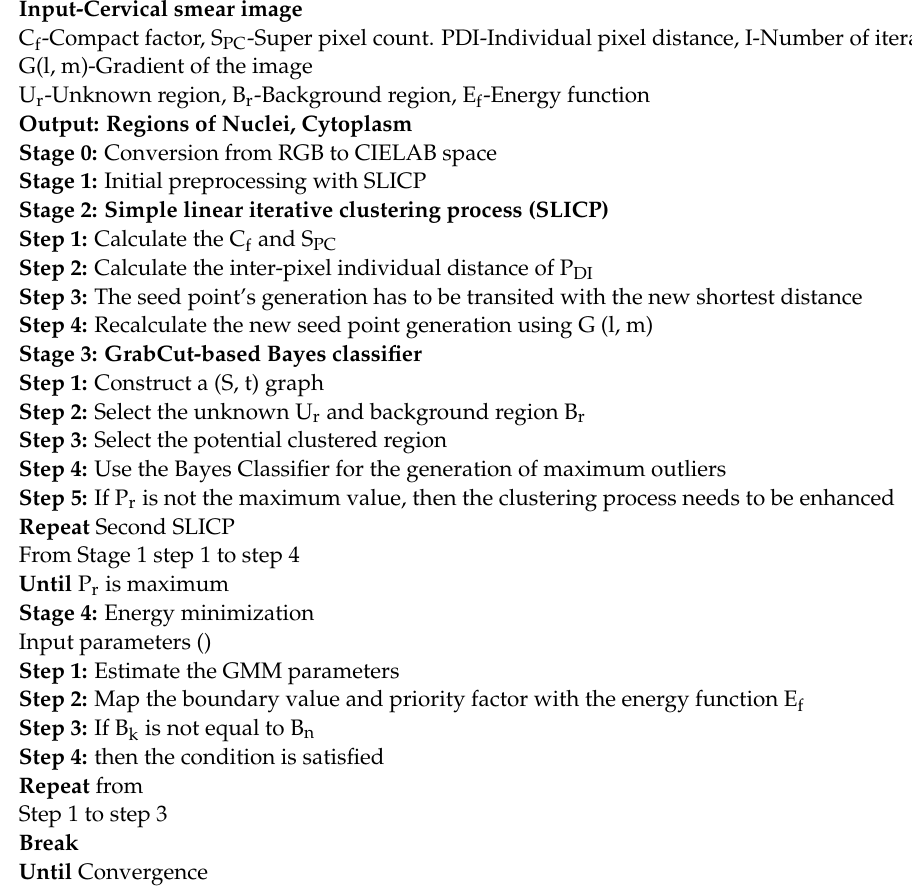
Algorithm 1. Proposed HLC-BC-GCS Scheme Input-Cervical smear